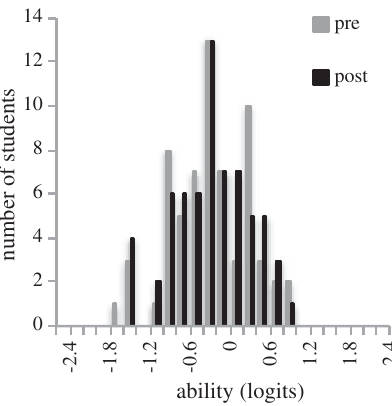
FIG. 40. The pre- and postability histogram for class 26.